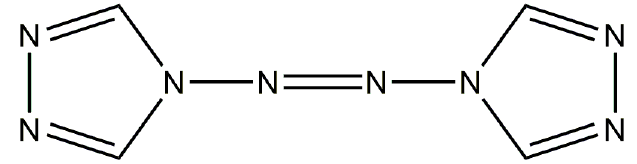
Figure 1. Molecular structure of ATRZ.